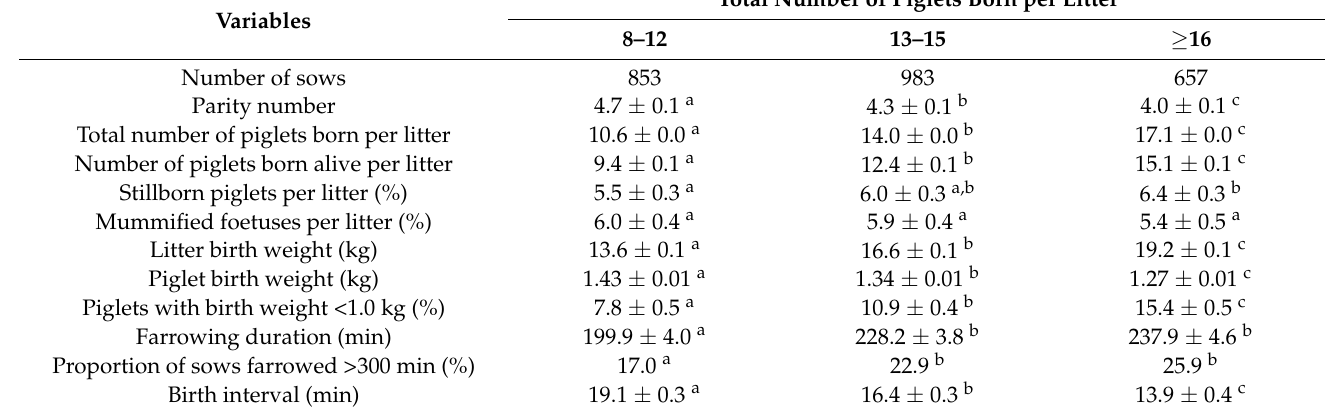
Table 3. Reproductive performances and farrowing characteristics of sows by the total number of piglets born per